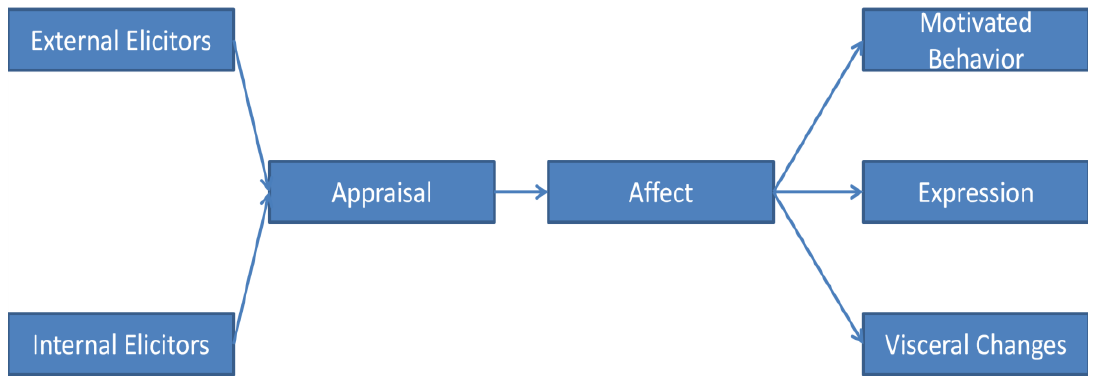
Figure 1. Basic schematic of constituents and their temporal sequence of